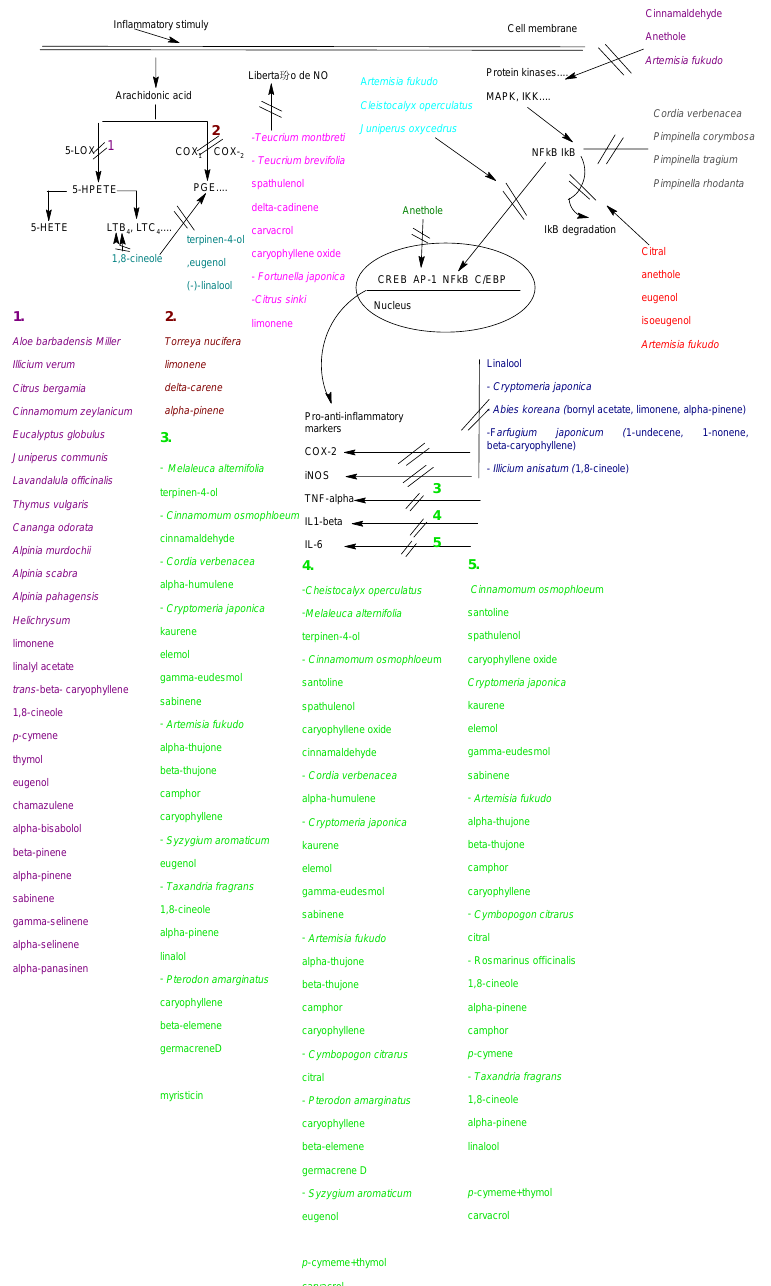
Figure 1. Essential oils and their main components in the modulation of the anti- inflammatory response. The pathways are described in the text together with the examples of essential oils and